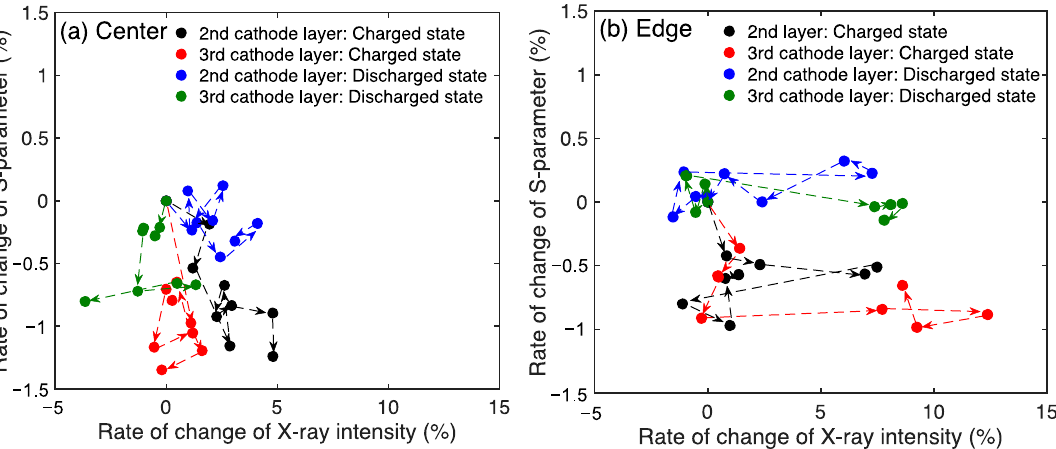
Figure 6. Correlation between the rate of change of the Compton scattered X-ray intensities and S − parameters at ( a ) the center position and ( b ) the edge position.